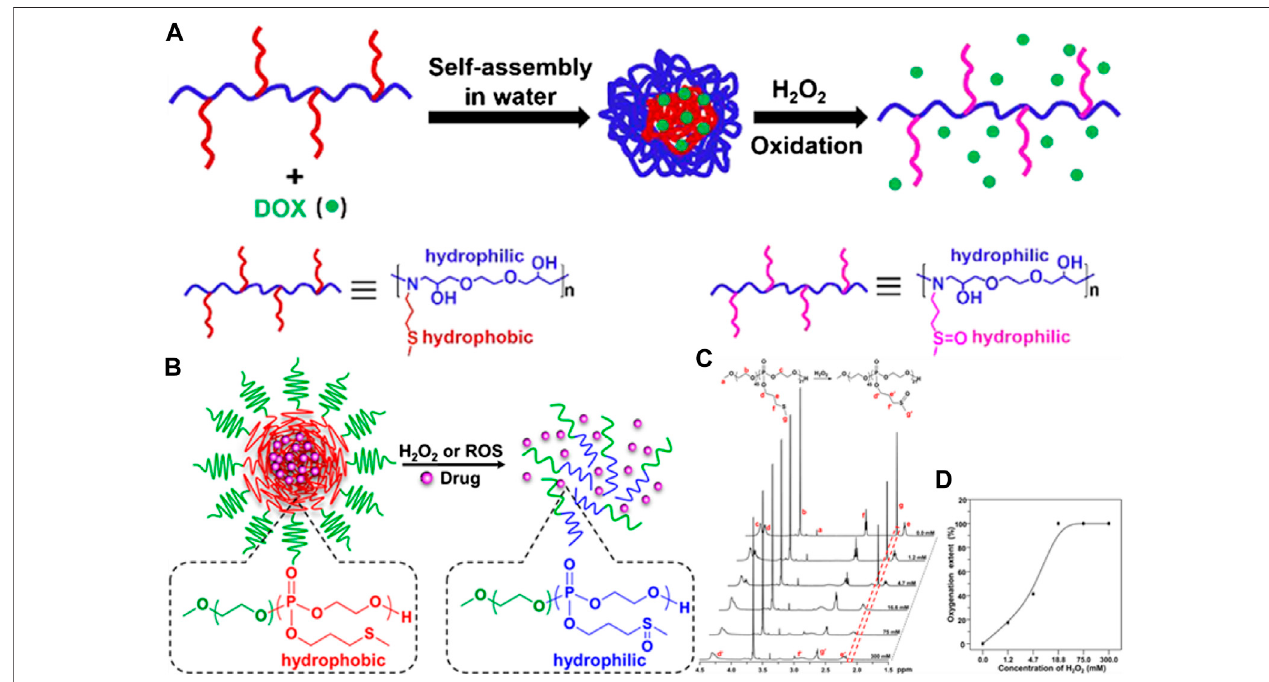
FIGURE 3 | (A) The chemical structure of thioether side chain polymer carriers and the drug release behavior of DOX-loaded P(MSPA- α -EG) micelles (Wang et al., 2019).Copyright2019, theAmericanChemical Society. (B) Schematic illustration ofthiother-pendant monomers MSPEP forpolymerizationofROS-responsive carriers (C) 1H NMR spectra of mPEG-b-PMSPEP carried out following oxidation in the presence of different H 2 O 2 concentrations. (D) Oxygenation degree of mPEG-b- PMSPEP in the presence of different H 2 O 2 concentrations (Wang et al., 2019). Copyright 2019, the American Chemical